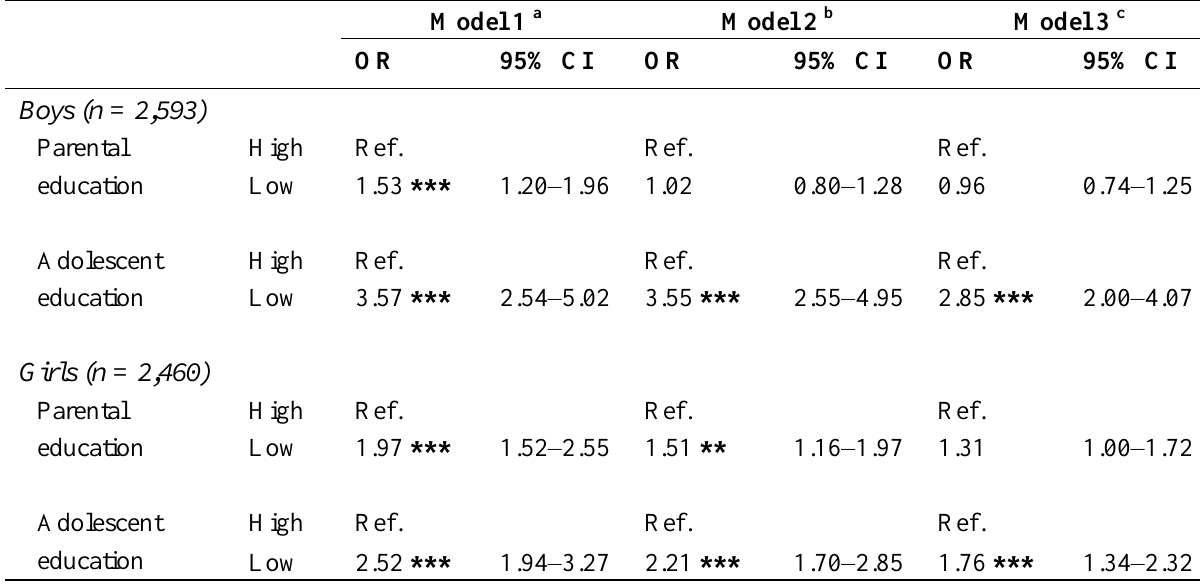
Table 3. Logistic regression analyses of parental and adolescent education levels and smoking among 12- to